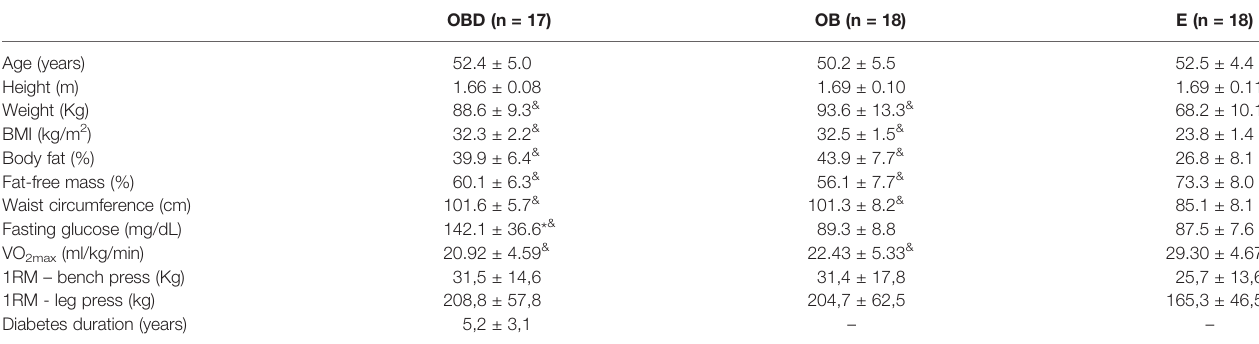
TABLE 1 | Anthropometric measurements, body composition, functional capabilities and fasting glucose of obese diabetic (OBD) or Obese without associated disease (OB) or Eutrophic (E) middle-aged individuals.